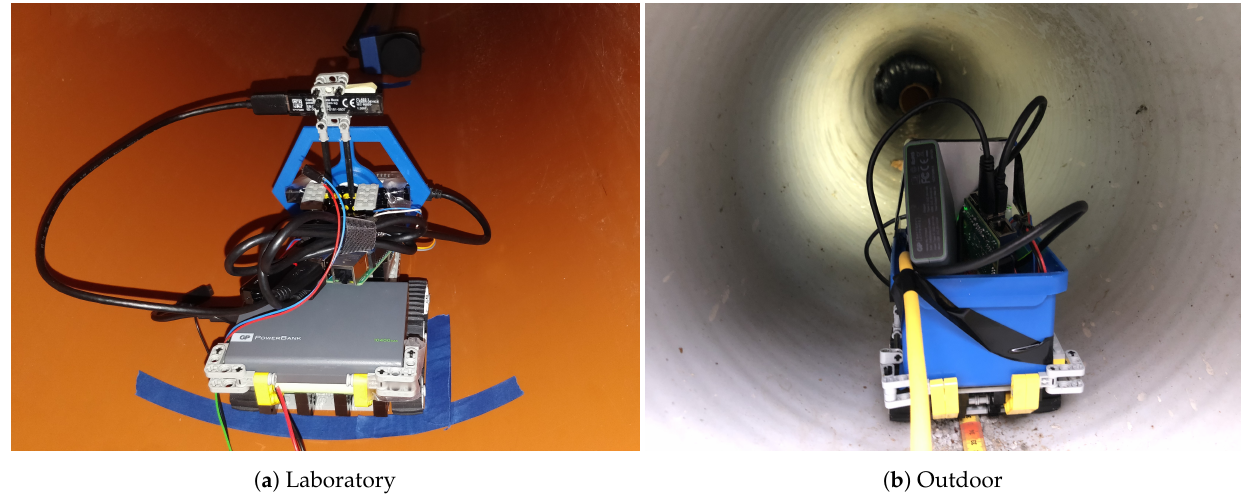
Figure 10. View of the LEGO-based robot located in the laboratory ( a ) and outdoor ( b ) pipes. The lux meter is visible in the top of image ( a ). The lux meter was not present during the recording of sensor